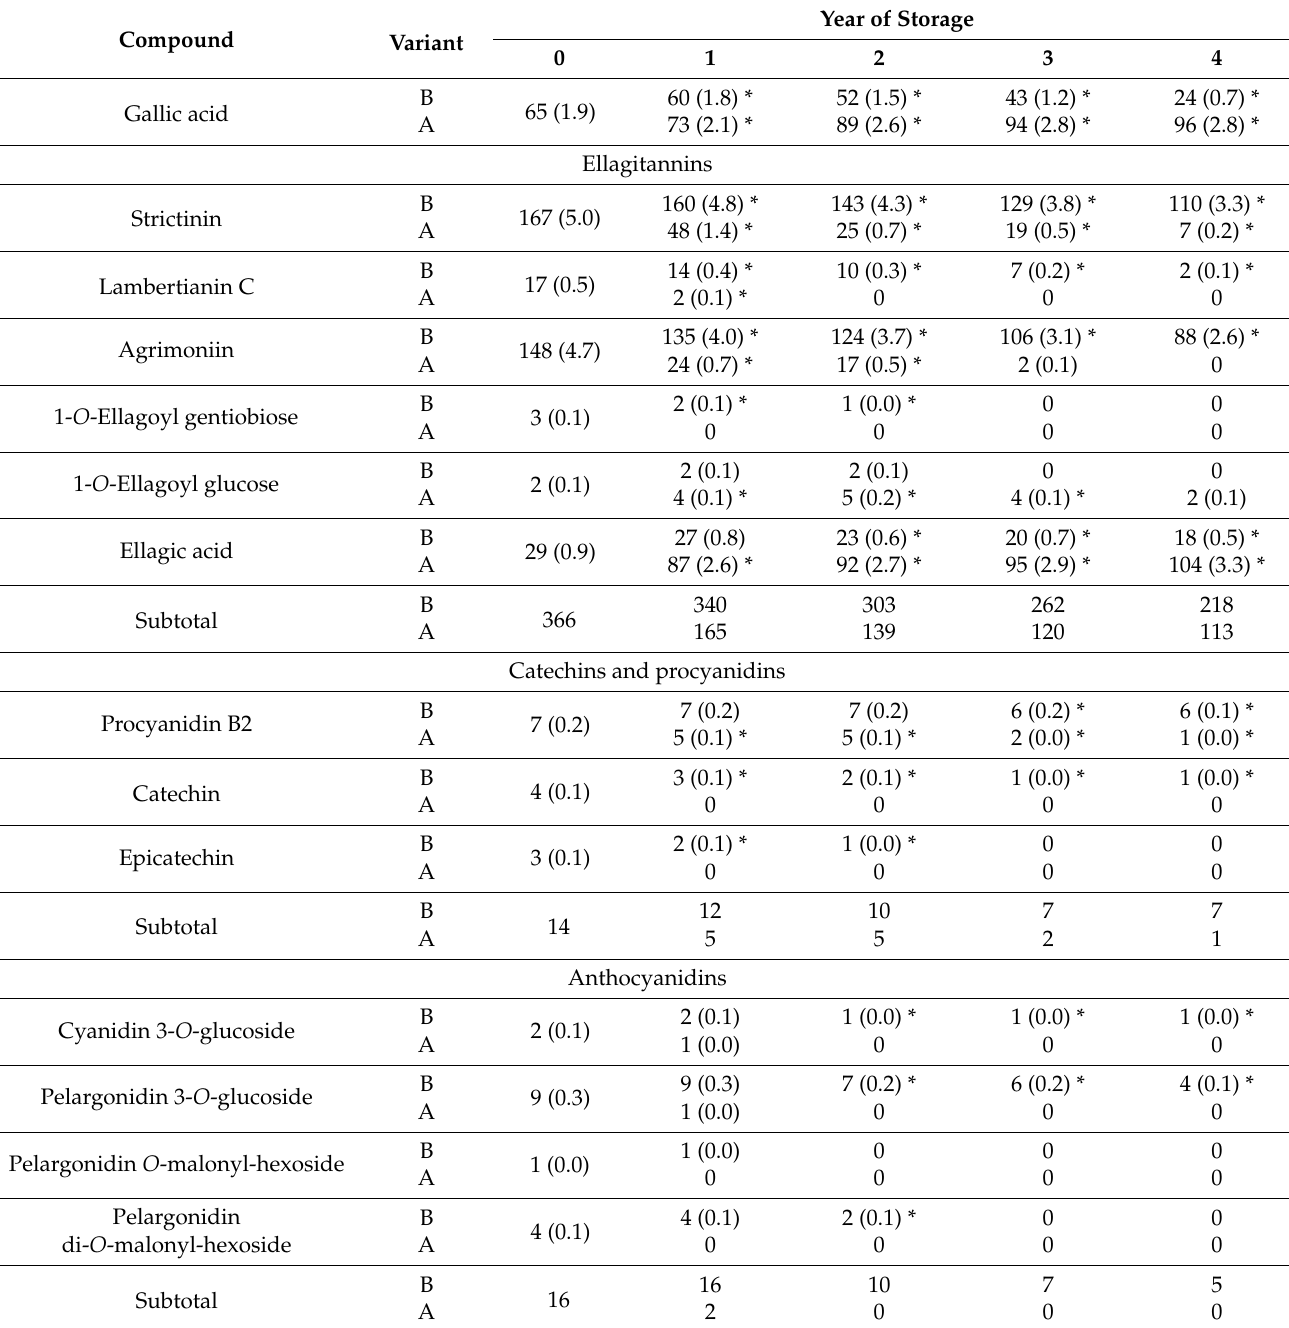
Table 5. Content of 20 phenolic compounds and ascorbic acid (mg/100 g fresh weight) and antioxidant potential ( µ mol trolox eq./100 g fresh weight) of F. orientalis fruits during storage at − 20 ◦ C (4 years), before (B) and after (A)